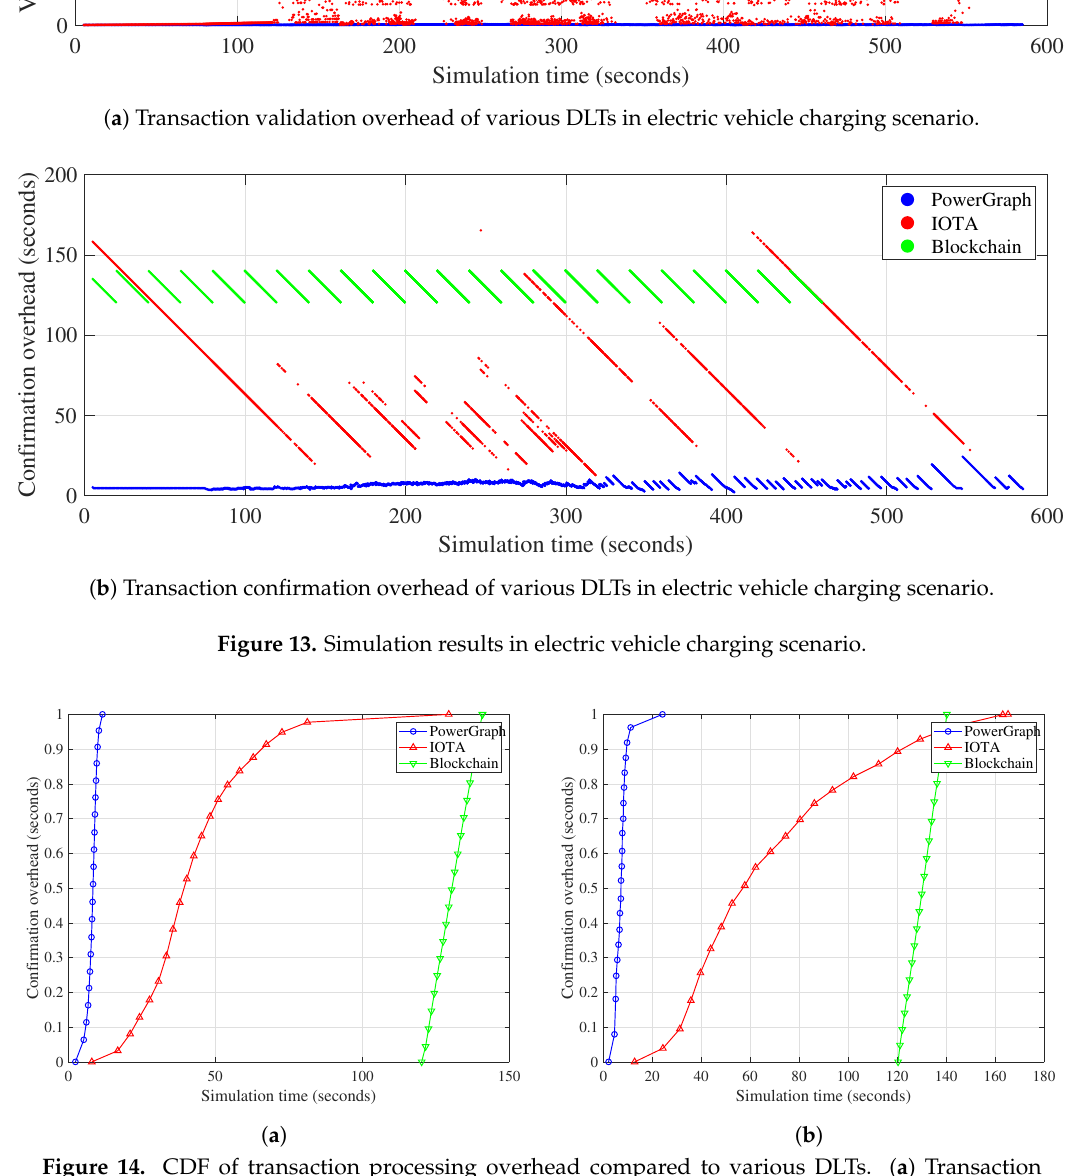
Figure 14. CDF of transaction processing overhead compared to various DLTs. ( a ) Transaction processing overhead CDF of various DLTs in IEEE 16 node test feeder scenario; ( b ) Transaction processing overhead CDF of various DLTs in electric vehicle charging